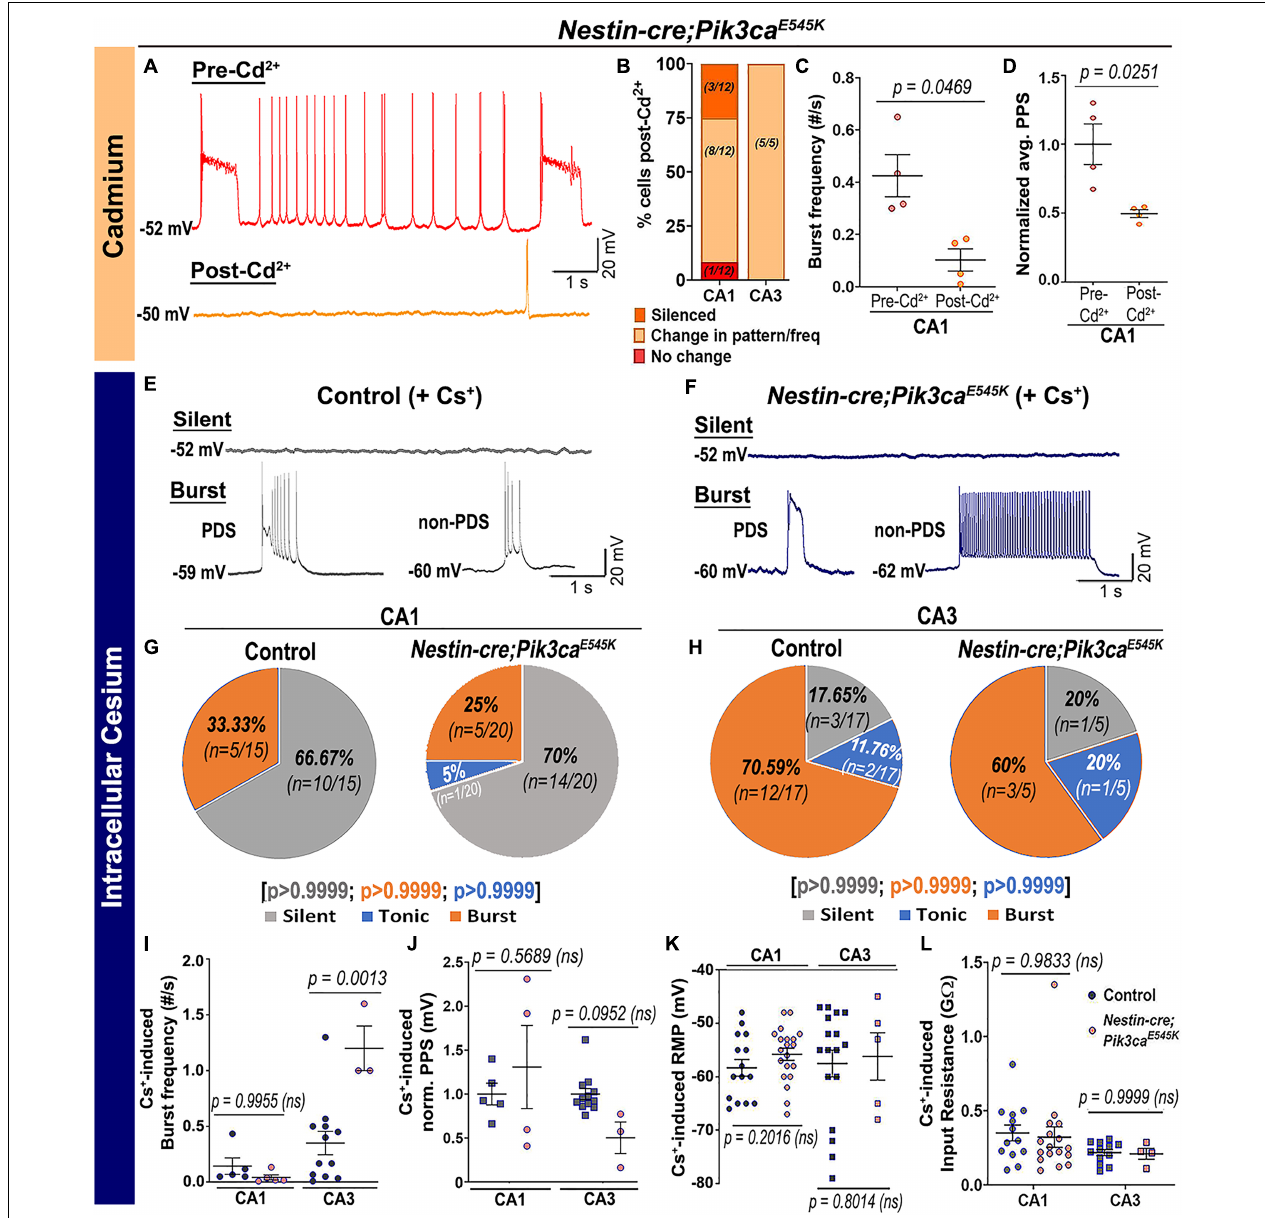
FIGURE 5 | Pik3ca-related burst characteristics are dependent on cell-intrinsic calcium and potassium channel regulation. (A–D) Blocking calcium channels by extracellular cadmium (Cd 2 + ) significantly altered the intrinsic bursting pattern of mutant neurons including burst frequency ( t = 3.267, df = 3) and PPS ( t = 4.172, df = 3). (E–H) Representative traces and respective pie charts show types of cellular activity in control and mutant CA1 and CA3 neurons after administering cesium intracellularly. In response to cesium, tonic firing cells were significantly reduced and original differences in CA1 and CA3 cell proportions between control and mutant were normalized. (I) Cs + -induced burst frequency was significantly higher in mutant CA3 than those in respective controls ( F = 26.31, df = 21); unlike normal spontaneous state, no such difference was observed in CA1. (J–L) Intracellular cesium lowered the spontaneously enhanced mutant PPS in CA1 to control levels ( F = 4.003, df = 20), while having no effect on RMP (CA1: t = 1.308, df = 27.32; CA3: t = 0.2616, df = 6.816) or input resistance ( F = 2.936, df = 42) in both control and mutant neurons. Data is represented as pie charts, % bar graphs and mean ± SEM scatter plots; differences were considered significant at p < 0.05; ns, not significant. Scale bars: 1 s, 20 mV (A,E,F)